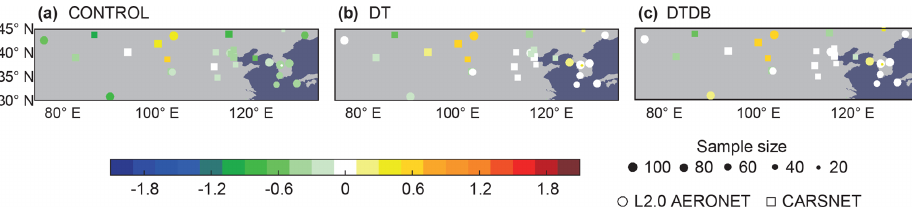
Figure 4. Fractional bias for aerosol optical depth at 440nm with respect to AERONET (circles) and CARSNET (squares) data: panel (a) shows the experiment CONTROL, panel (b) shows experiment DT (with only Dark Target MODIS retrievals in the assimilation), and panel (c) shows experiment DTDB (with both Dark Target and Deep Blue MODIS retrievals in the